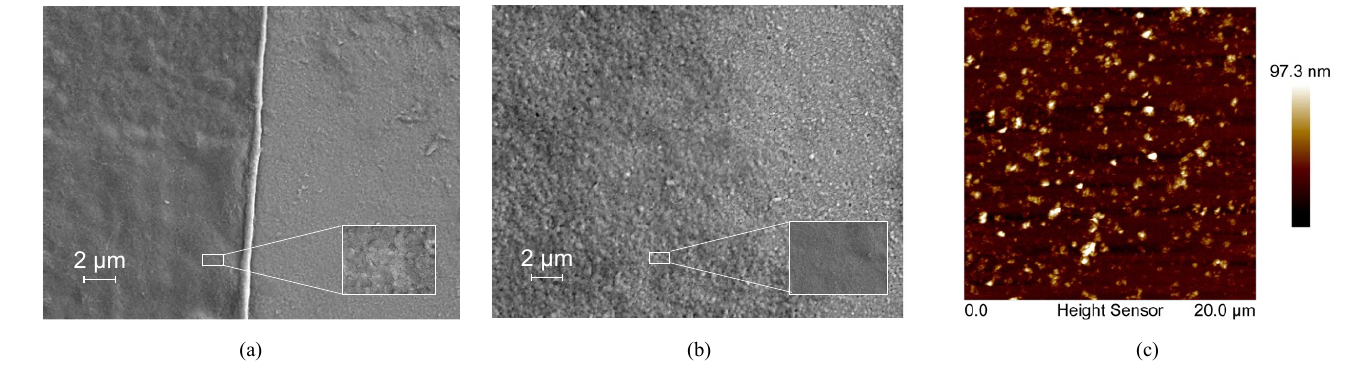
Figure 1. Topographical characterization of bacteriorhodopsin films immobilized with different techniques. ( a ) SEM image of the dropcasted film. A clear edge and uniformly distributed bR film indicates a good immobilization quality. ( b ) SEM image of the electrophoretic sedimented film. A clear edge and uniformly distributed bR film indicates a good immobilization quality. ( c ) AFM image of the Langmuir–Blodgett deposited film. The bR molecules are uniformly deposited on the substrate with a peak height of 97.3 nm, corresponding to three monolayers of bR.